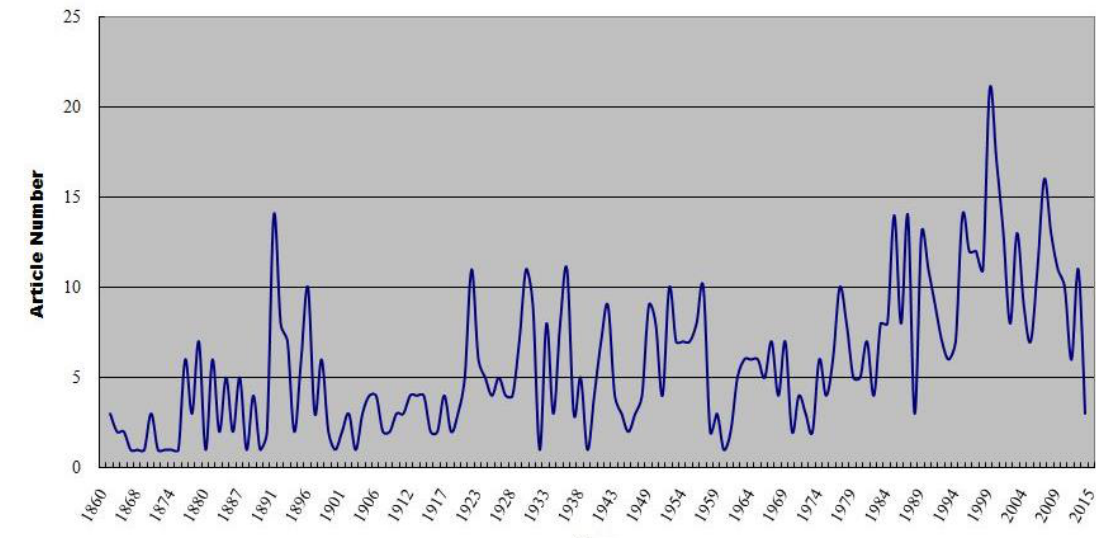
Figure 1. Annual number of articles on Mordellidae over the period from 1864 through 2013.